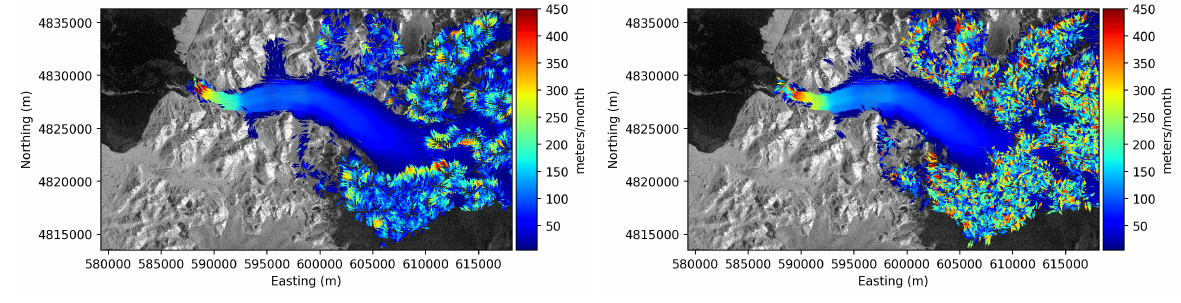
Figure 3. San Rafael Glacier surface velocity field: seasonal